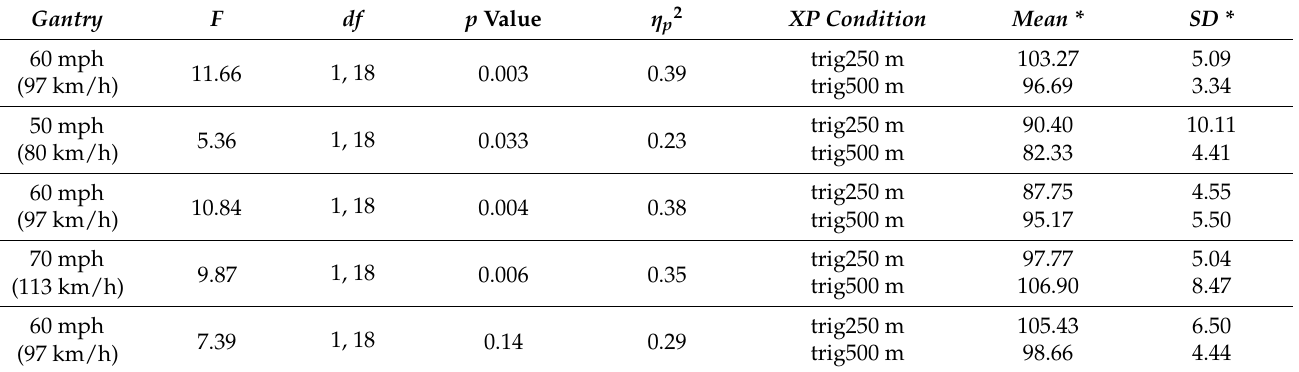
Table 8. Analysis of variance to compare the speed at each gantry between both experimental groups.